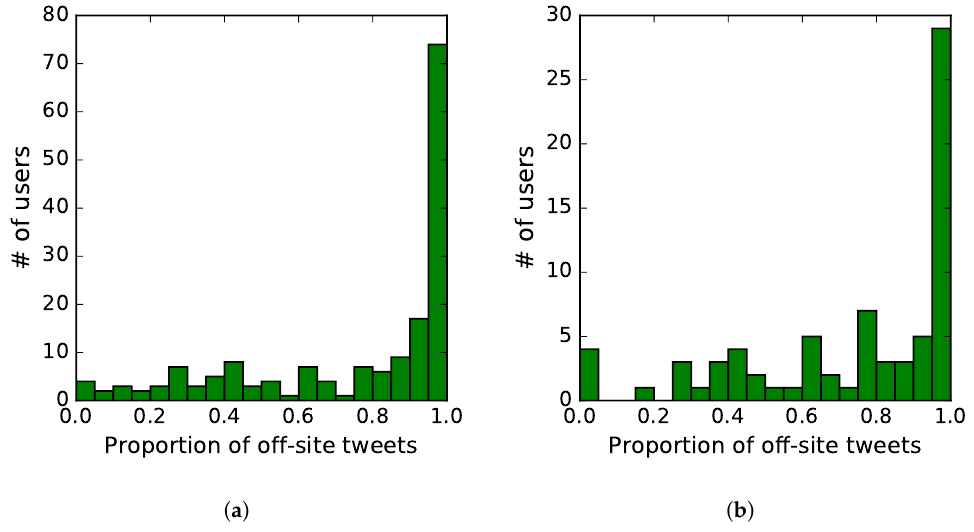
Figure 8. Histogram of off-site twitting users. ( a ) all clusters; ( b ) the clusters with more than a mean number of